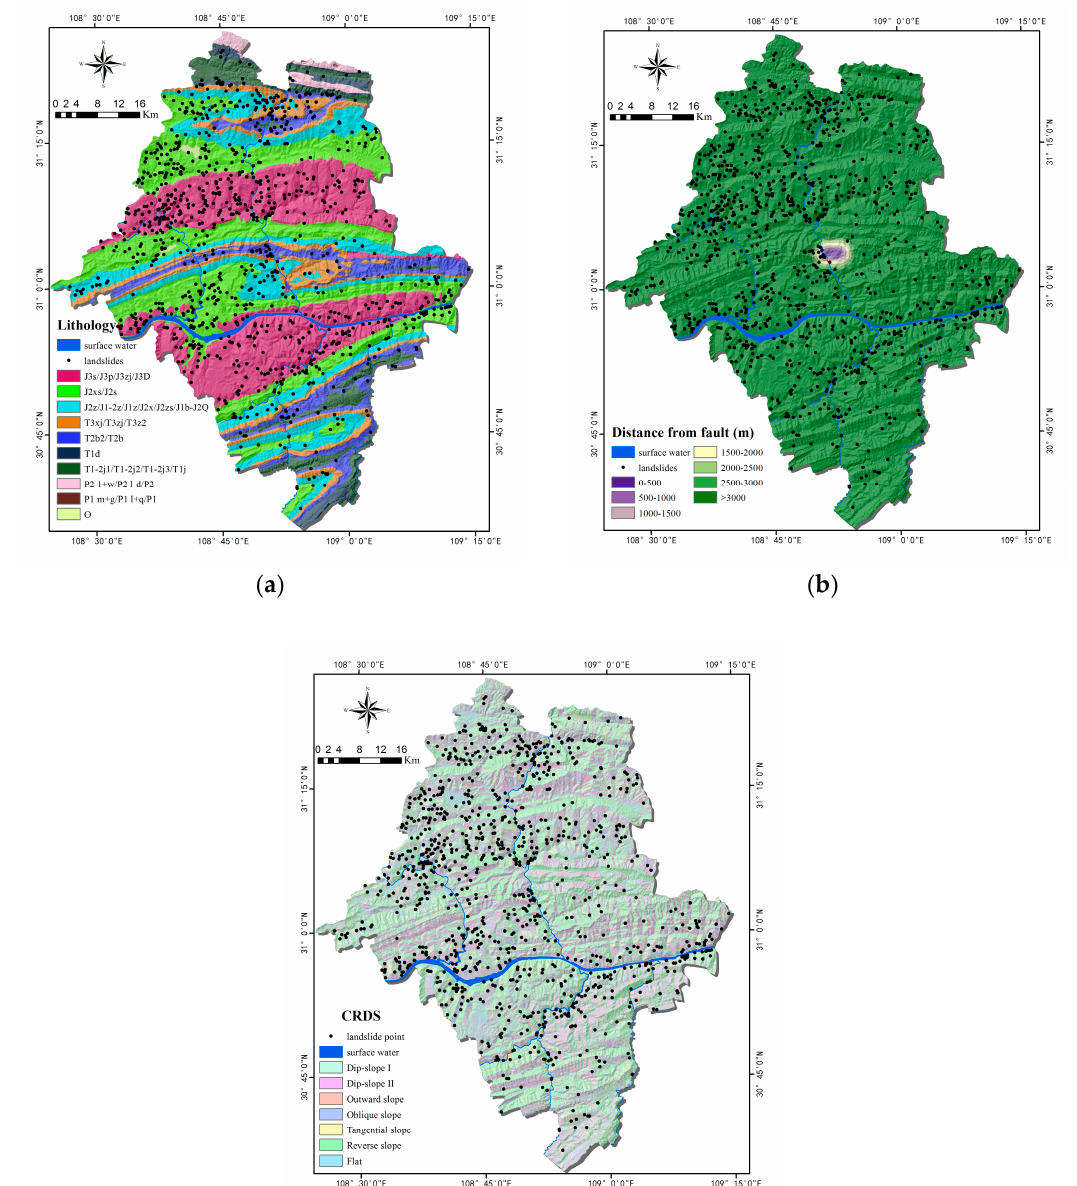
Figure 7. Thematic maps of geological factors: ( a ) Lithology; ( b ) Distance from fault; ( c ) The combination reclassification of stratum dip direction and slope aspect (CRDS).